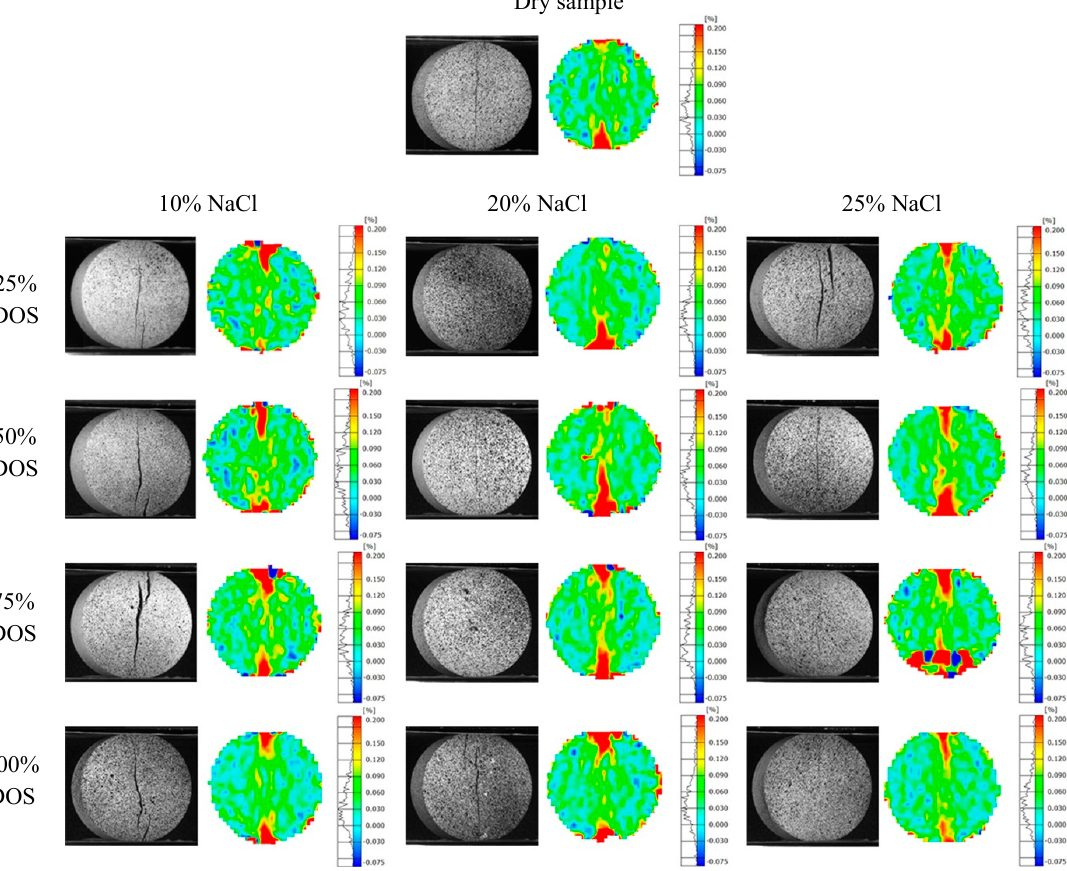
Fig. 9. ARAMIS strain distribution (-0.075% – 0.2%) and failure pattern in STS specimens 23 Figure 9. ARAMIS strain distribution ( − 0.075%–0.2%) and failure pattern in STS specimens for 10%, 20% and 25% NaCl concentrations for 25%, 50%, 75%, and 100% degree of saturation for 10%, 20% and 25% NaCl concentrations for 25%, 50%, 75% and 100% DOS. 24